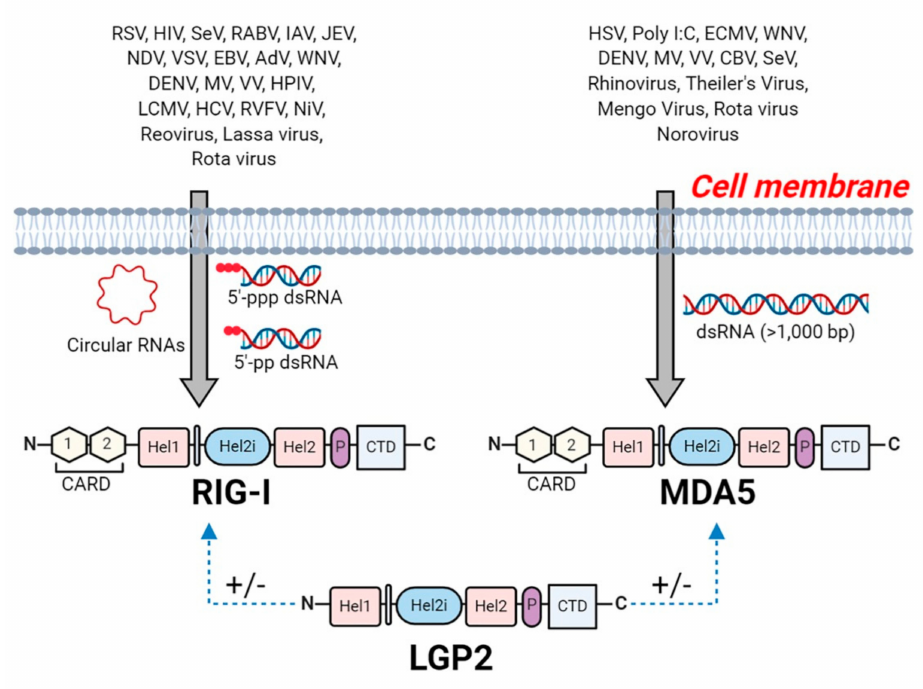
Figure 3. Structure of retinoic acid-inducible gene I (RIG-I)-like receptor, melanoma differentiation-associated gene 5 (MDA5) and laboratory of genetics and physiology 2 (LGP2). Viral detectors, RIG-I and MDA5 share a similar structural pattern: N-terminal region with two caspase activation and recruitment domains (CARDs) and a central DECH-box helicase domain. The helicase domain consists of two Hel-1 and Hel-2, and between them lies a helicase insert domain (Hel2i); the pincer domain and C-terminal domain (CTD). On the other hand, LGP2 lacks the CARD domain and is implicated as a positive or negative regulator of RIG-I and MDA5 (indicated as +/ − ). RIG-I senses dsRNAs bearing 5 (cid:48) triphosphate (5 (cid:48) -ppp) moiety or 5 diphosphate (5 (cid:48) -pp) end, and circular RNA (circRNAs); while MDA5 senses long dsRNA (>1000 bp) with no end specificity. RSV: Respiratory syncytial virus; HIV-1: Human immunodeficiency virus 1; SeV: Sendai